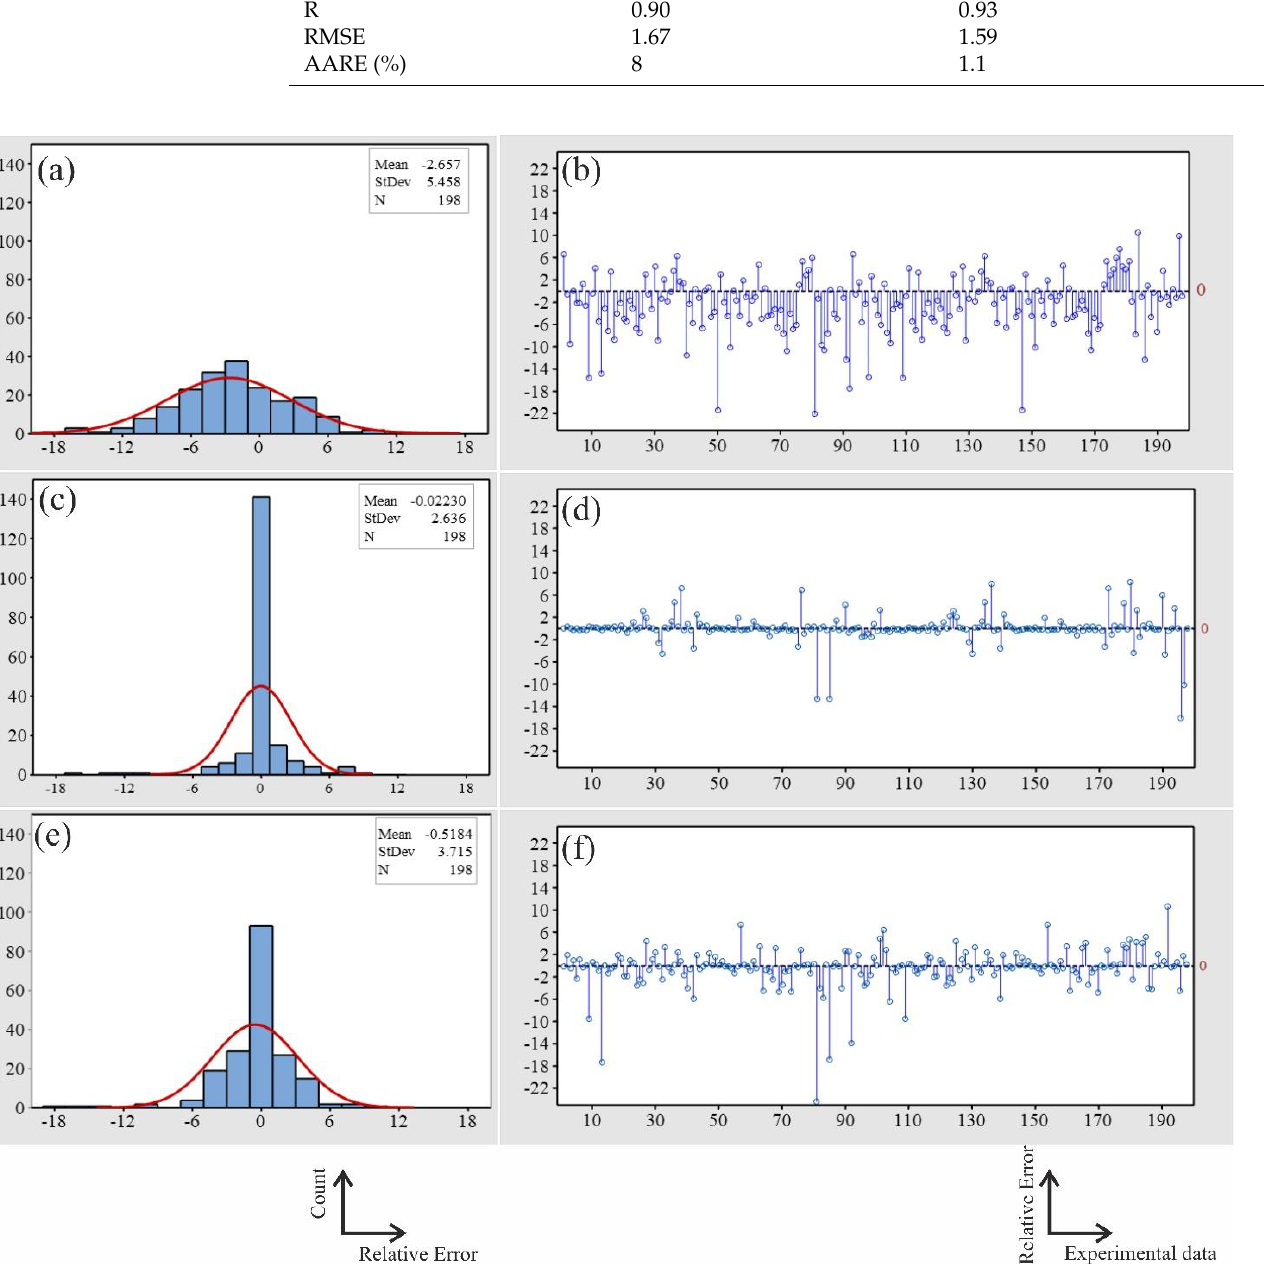
Figure 10. The error histograms and the error plots for the predicted stress of the ANN model with ( a , d ) one layer, ( b , e ) two hidden layers, and ( c , f ) three hidden layers.